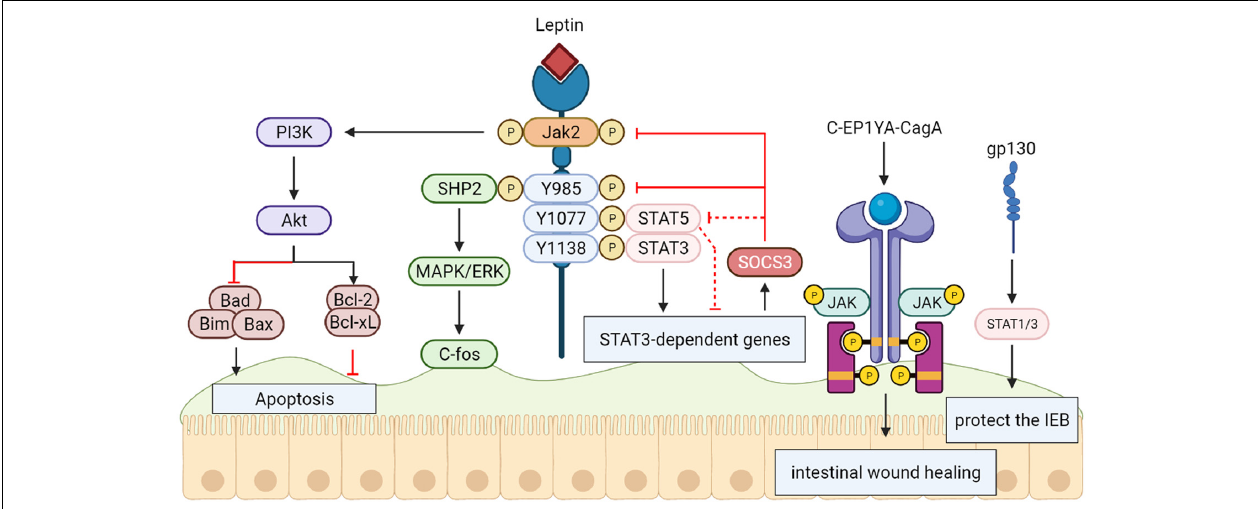
FIGURE 5 | Signal transducers and activators of transcription 3 (STAT3) protect the intestinal epithelial barrier. The activation and tyrosine phosphorylation of Janus kinase 2 (JAK2) are resulted in by Leptin binding to the long form LRb, which causes follow-up phosphorylation of downstream tyrosine residues (Tyr985, Tyr1077, and Tyr1138) in the intracellular tail of LRb. The phosphorylation-dependent activation of signal transducers and activators of transcription 3 (STAT3) are bound and mediated by Phosphorylated Tyr1138, activating transcription of suppressor of cytokine signaling 3 (SOCS3) and other positive effectors of leptin action. The